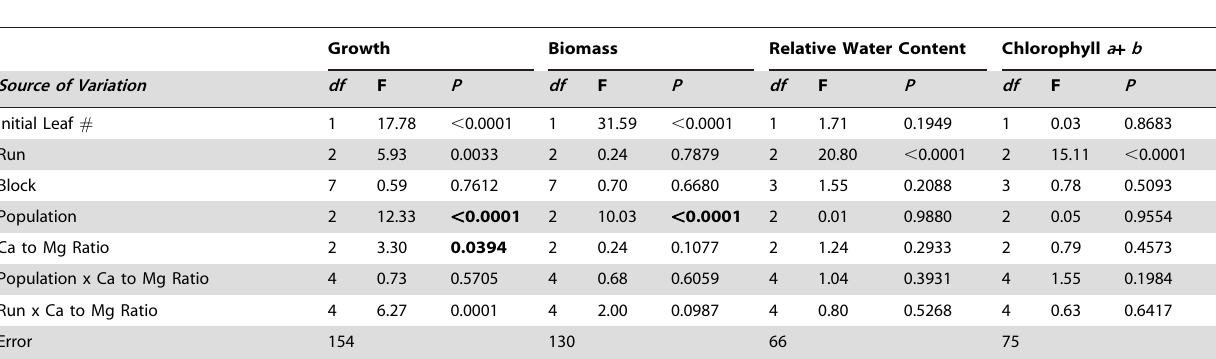
Table 3. ANOVA table for rosette growth (leaves per week), biomass, relative water content, and total chlorophyll ( a + b ) of three A. l. ssp. lyrata populations exposed to different substrate Ca to Mg ratios.